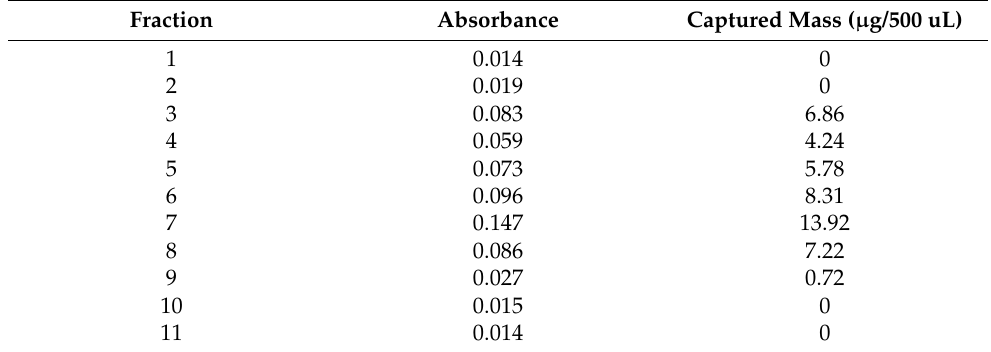
Table 1. Protein quantification using the bicinchoninic acid (BCA) assay method, after recovery of 11 fractions obtained from the elution profile. Fraction Absorbance Captured Mass ( µ g/500 uL) 1